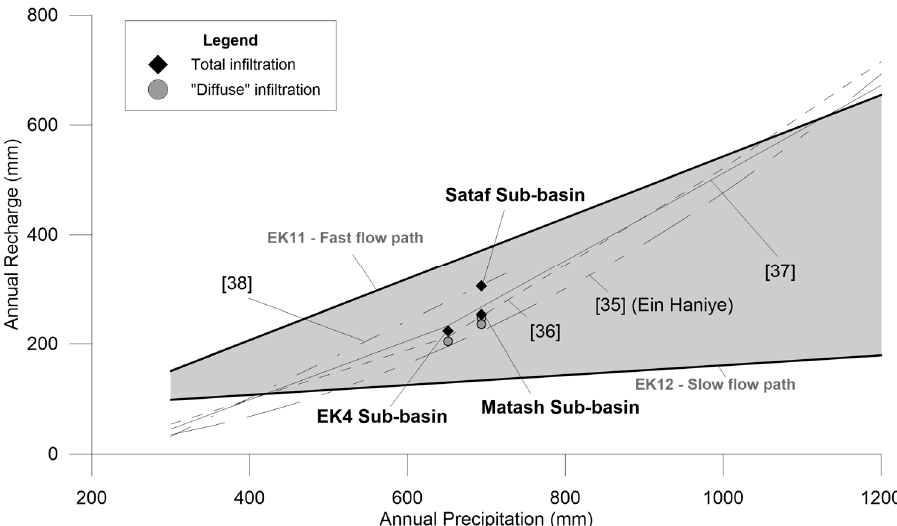
Figure 7. Computed annual recharge of total and diffuse infiltration at the EK4, Sataf, and Matash sub-basins over the expected recharge range (grey) at the study area [32]. The recharge range is between fast flow paths along conduits and slow flow paths through the matrix. EK11 and EK12 are sites that represent these two different types of flow paths, respectively.